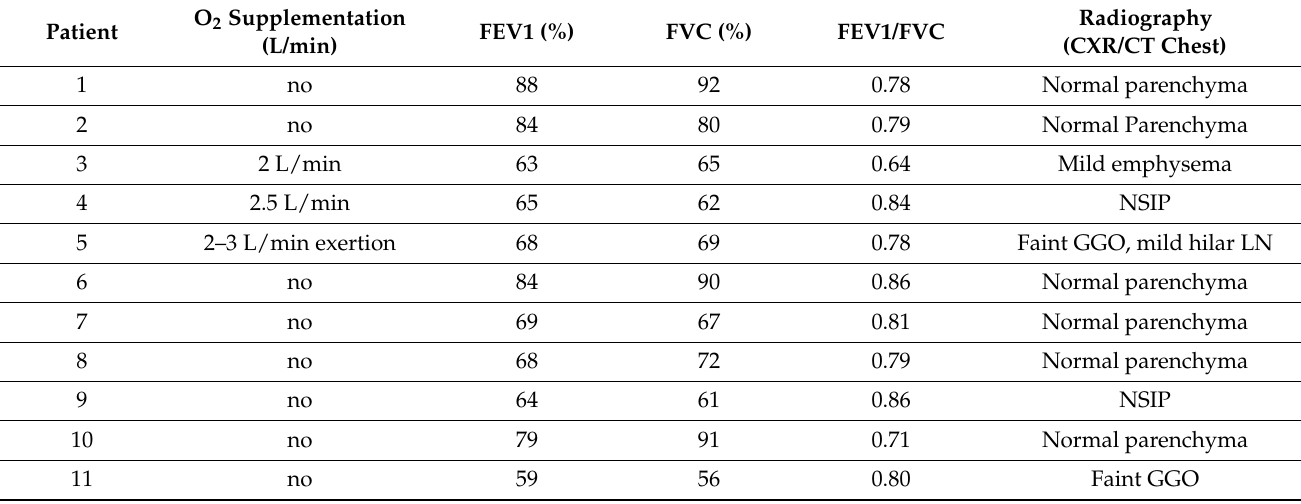
Table 3. Baseline respiratory system